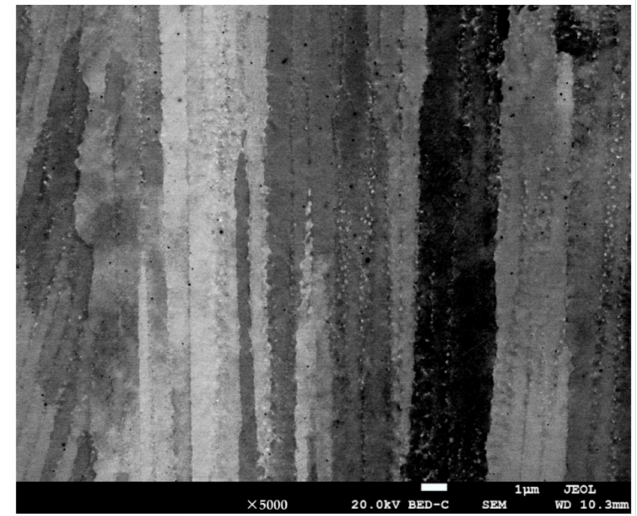
Figure 13. Solidified microstructure of Ni(Bal.)-3.2Al-0.1C-8.5Co-16.3Cr-1.65Mo-1.8Ta-3.22Ti-2.7W (wt.%) in the laser powder bed fusion